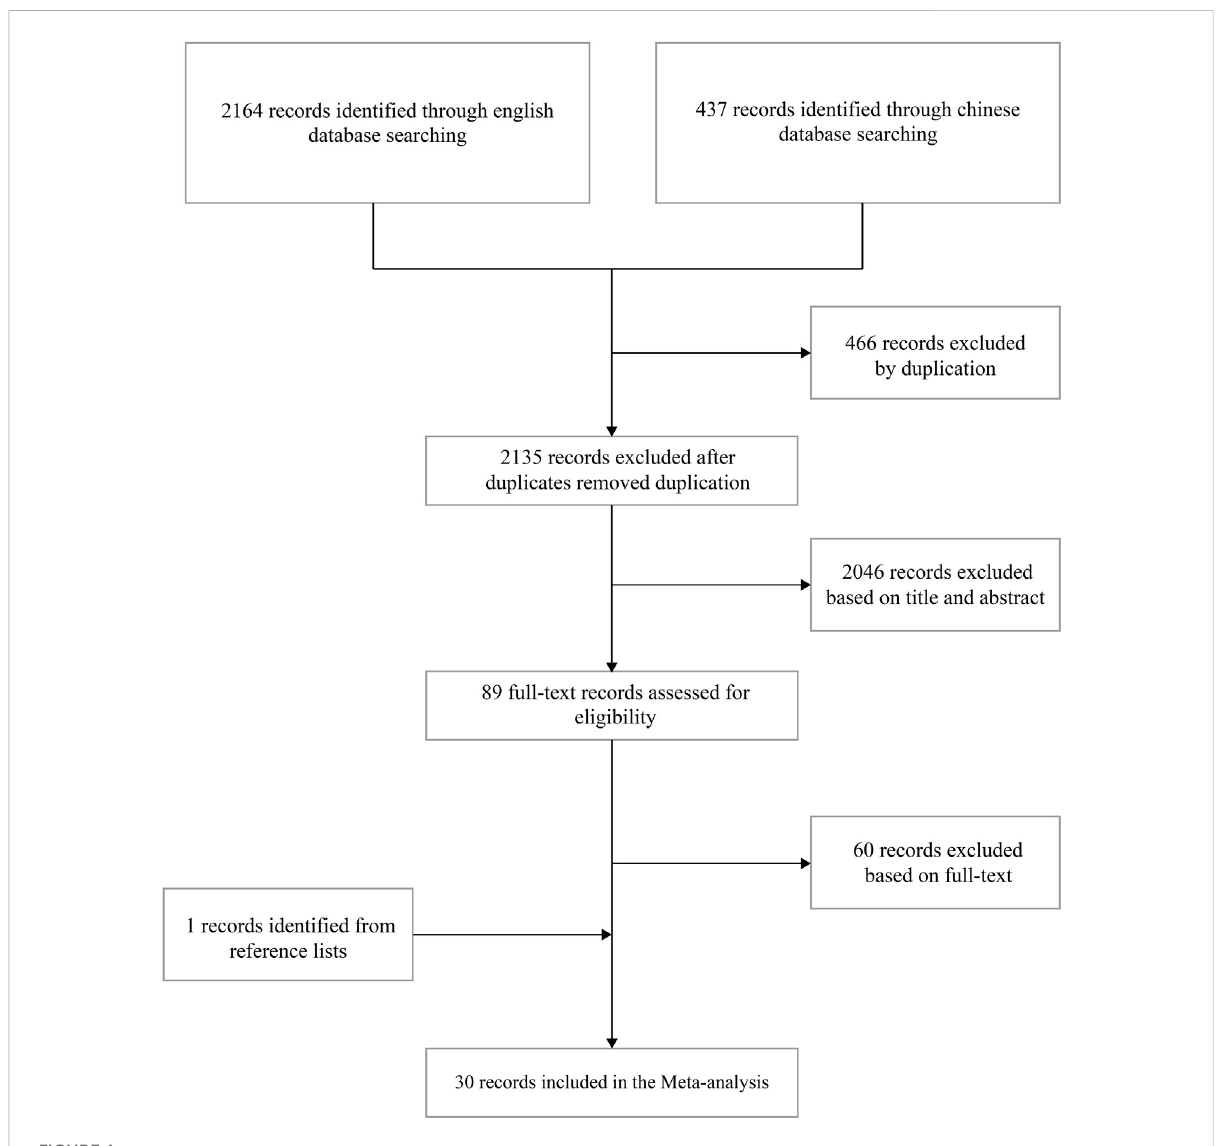
FIGURE 1 Study fl ow